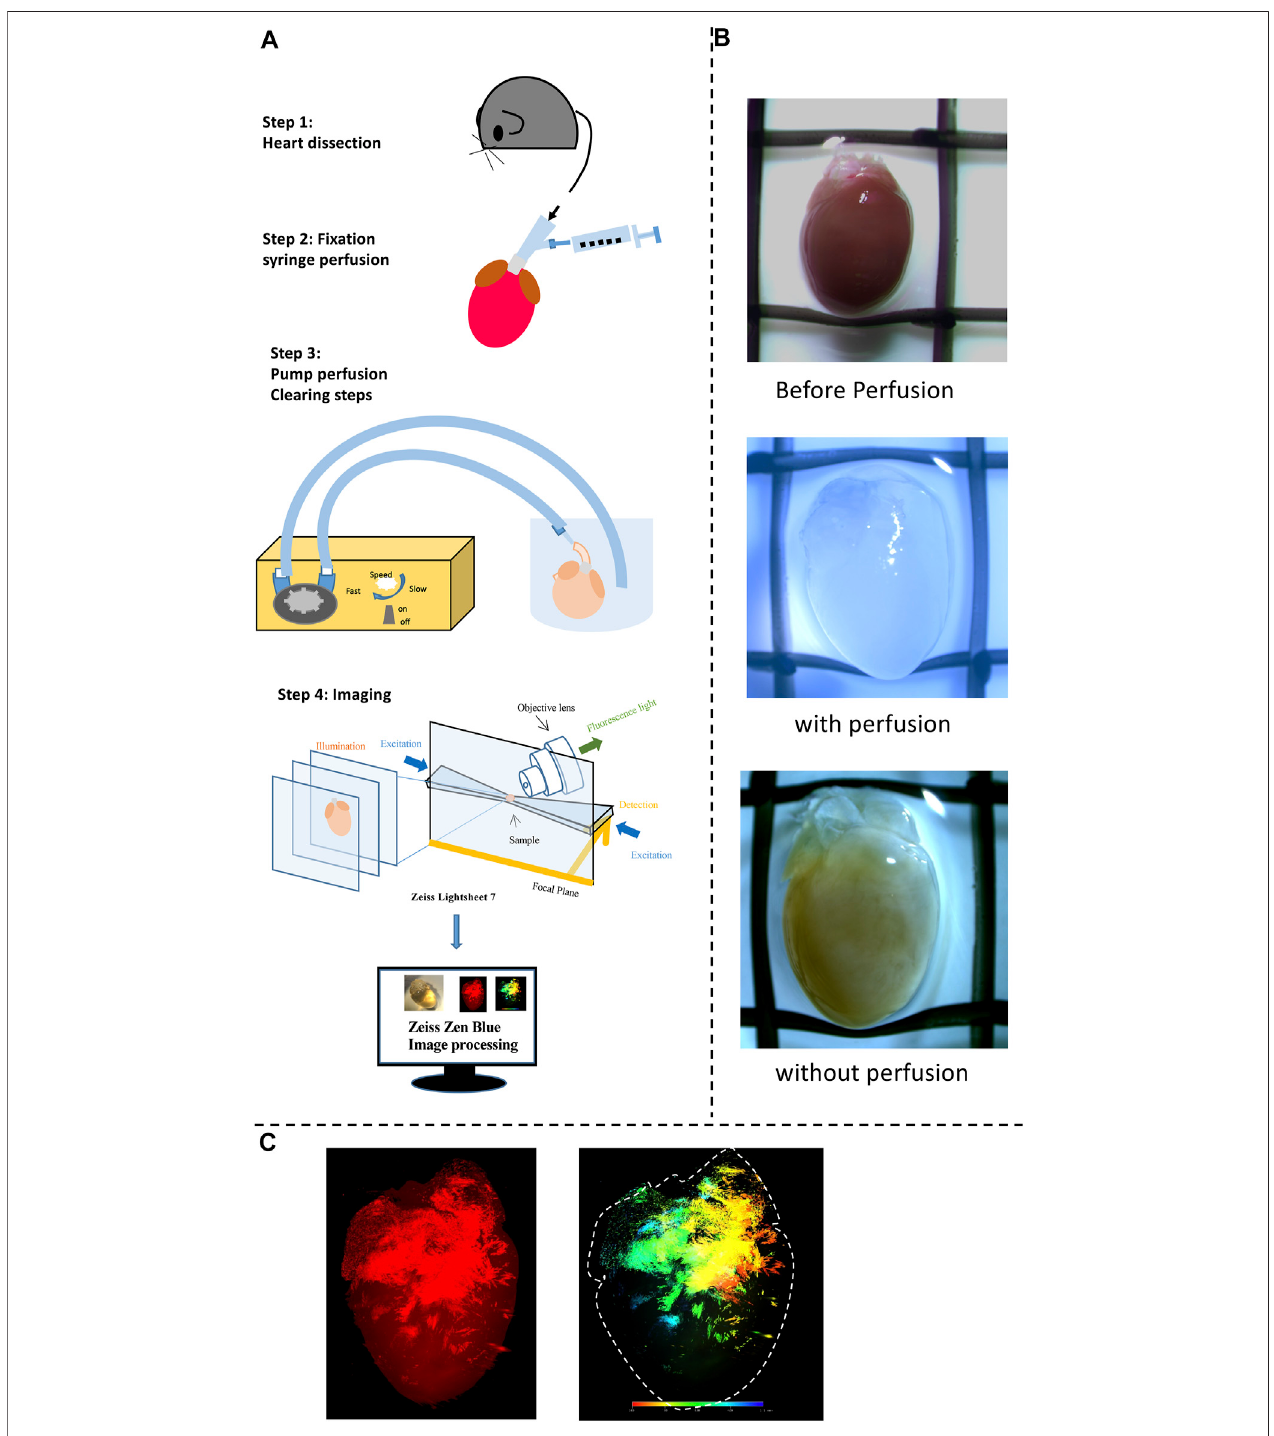
FIGURE 1 | A work fl ow for tissue clearing and examples of 3D reconstruction. (A) A schematic overview of the work fl ow of the study and the process of the experimental procedures. Heart dissection was conducted. Afterward tissue fi xation and clearing were done to obtain transparent hearts. Finally, Fluorescence images for detecting fl uorescent positive cells were obtained using Zeiss Fluorescent microscopy (provide the model details here) in transparent hearts; Diagram illustrating the procedureforthe3DreconstructionachievedusingtheZEISSZENsoftwaretopresentbothTdtomato fl uorescenceanddepthcolorcodemodels.3Dvolumedata (Videos 1 – 4) was visualized in Paraview following Gaussian smoothing and down-sampling. (B) Images of Heart samples showing the appearance before, with, and without the perfusion. (C) Examples of fl uorescence and depth code images for fi nal products.